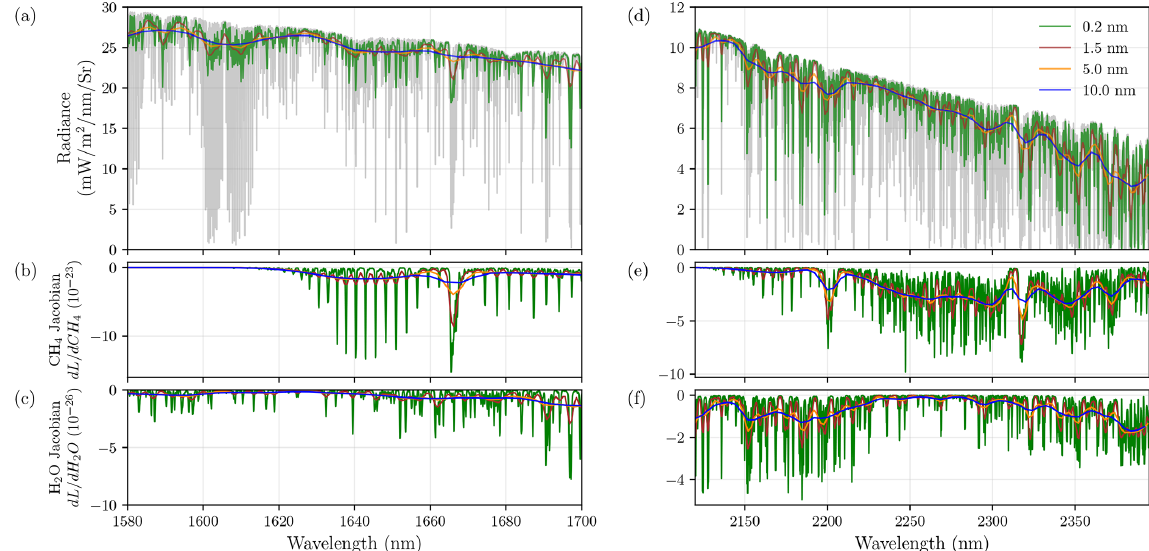
Figure 5. Simulated reflected solar radiance, through a plume of 200kgh − 1 , over a concrete surface, as observed by instruments of different FWHM in the two fitting windows of 1.6µm (a–c) and 2.3µm (d–f) . The gray background is the originally calculated spectra at 0.01nm.